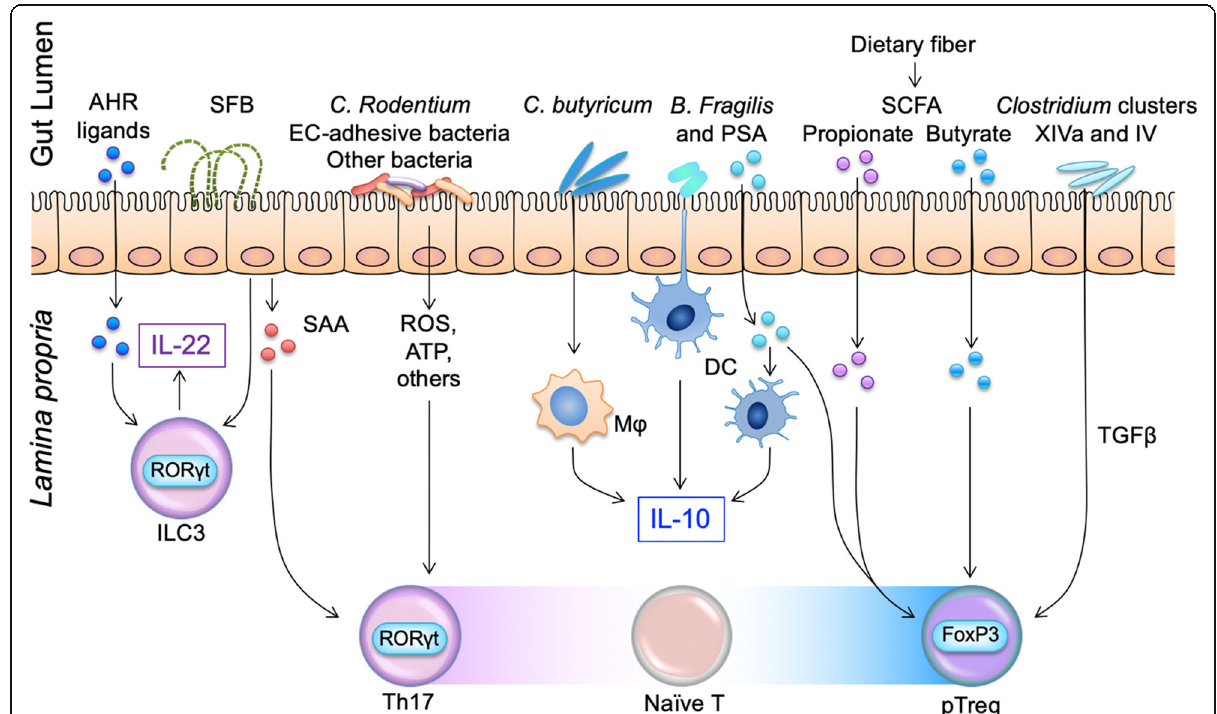
Fig. 2 Prebiotics, probiotics, and postbiotics each have specific associations with immune cells in the lamina propria. Aryl hydrocarbon receptor (AHR) ligands, which are present in food antigens, promote mucosal healing via IL-22 production from group 3 innate lymphoid cells (ILC3). SFB also promote IL-22 production from ILC3 and activate lamina propria DCs and macrophages to induce Th17 cells through the production of SAA from IECs. C. rodentium and epithelial cell (EC)-adhesive bacteria induce Th17 differentiation by reactive oxygen species (ROS), adenosine triphosphate (ATP), and others. C. butyricum induce intestinal IL-10-producing macrophages, while polysaccharide A (PSA)-positive B. fragilis stimulate DCs to produce IL-10. PSA itself directly promotes the development of the activation of Foxp3-positive Treg cells in a similar way to SCFA, such as propionate and butyrate. Clostridium clusters IV and XIVa also promote Treg cell accumulation via TGF- β production from